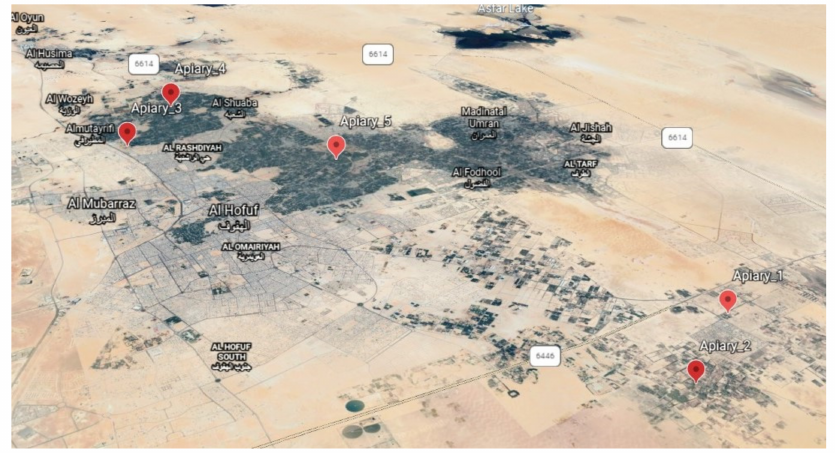
Figure 1. A map with the location of the experimental apiaries in the Al-Ahsa